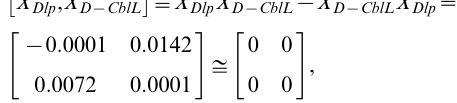
q ffiffiffiffiffiffiffiffiffiffiffiffiffiffiffiffiffiffiffiffiffiffiffiffiffiffiffiffiffiffi cosh 2 j { cos 2 g